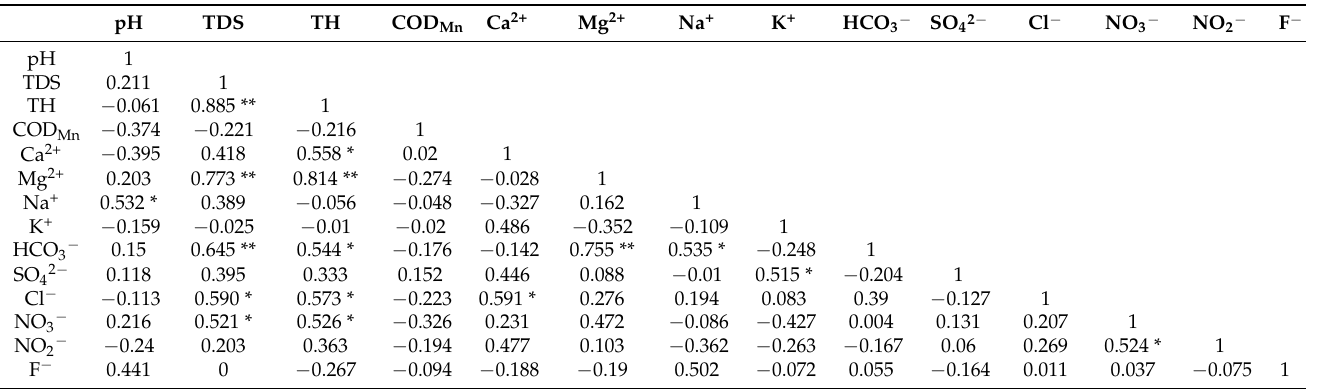
Table 5. Pearson correlation coefficients of